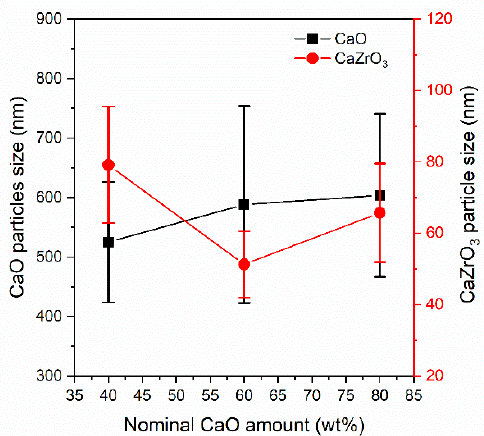
Figure 11. Average size of the CaO and CaZrO 3 particles measured by SEM after calcium looping cycles of the CCZ samples.